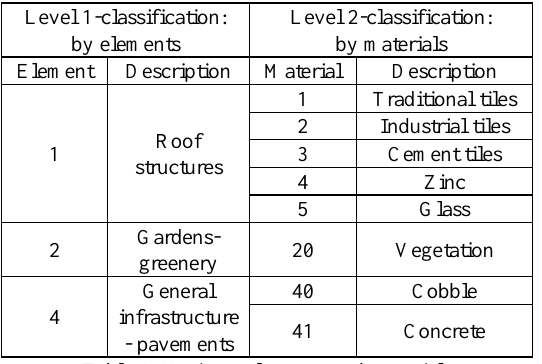
Table 1. Heritage elements and materials